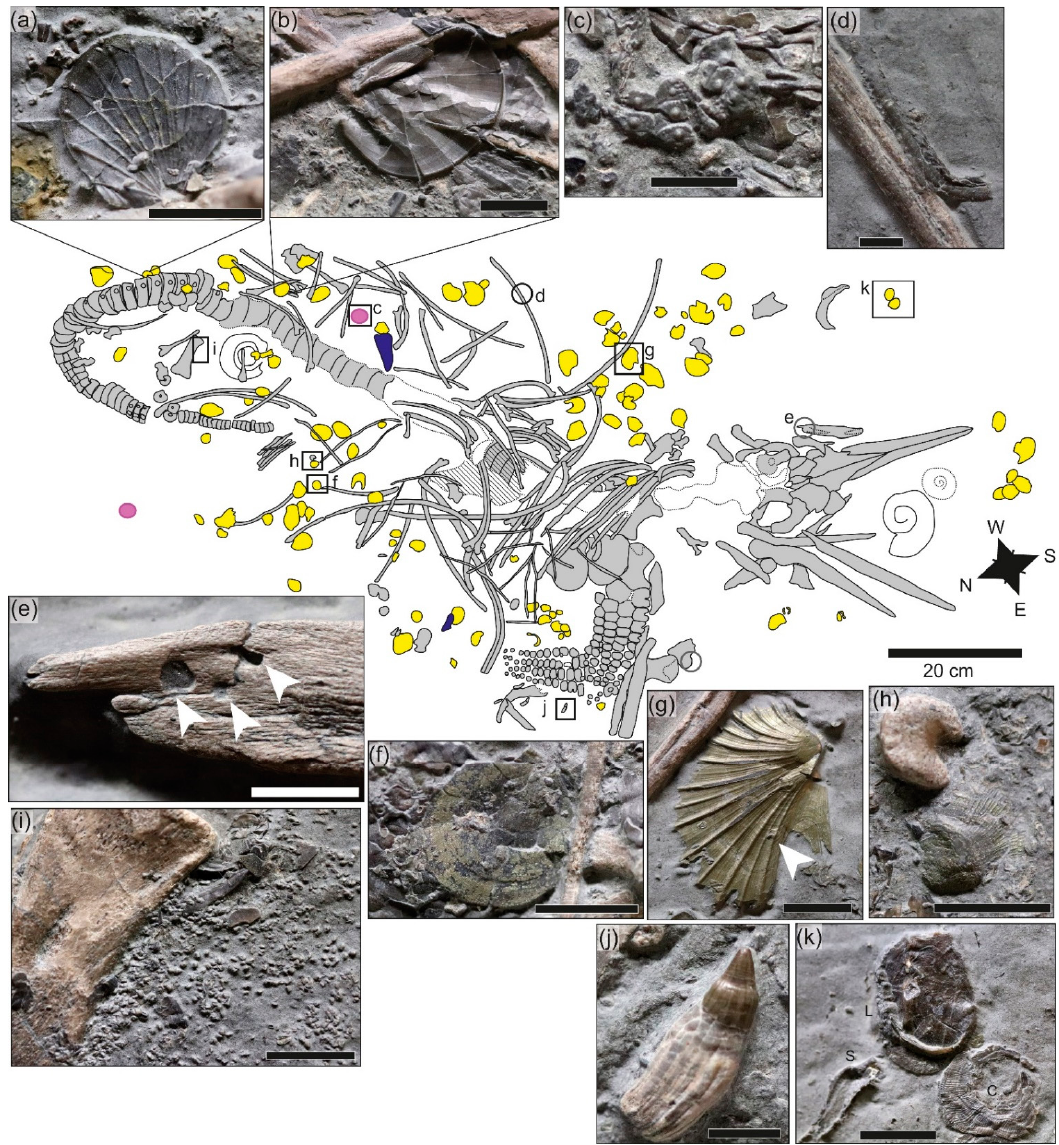
Figure 5. Macroinvertebrates associated with SMNS 81841, Stenopterygius quadriscissus ; hatching indicates the extent of the gastric contents. Bivalves are indicated in yellow, aptychi in dark blue, and echinoderms in pink. ( a ) Propeamussium pumilus ; ( b ) Plagiostoma sp.; ( c ) indeterminate partial echinoid test; ( d ) indeterminate serpulid encrusting a dorsal rib; ( e ) posterior maxilla in dorsal view showing borings, indicated by arrows; ( f ) Eopecten strionatis ; ( g ) Oxytoma inaequivalvis with articulated right and left valves and encrusted with small Liostrea (arrow); ( h ) Meleagrinella with ichthyosaurian pedal phalanx; ( i ) lateral ischiopubis showing accumulation of ophiuroid ossicles in the surrounding sediment; ( j ) ichthyosaur tooth with distinctive malformation of the crown; ( k ) fauna encrusting the upper surface of a dissolved ammonite shell: L, Liostrea , S, Serpulidae, C, “ Cucullaea” muensteri . Scale bars = 10 mm ( a , b , e – i , k ), 5 mm ( c , d , j ).